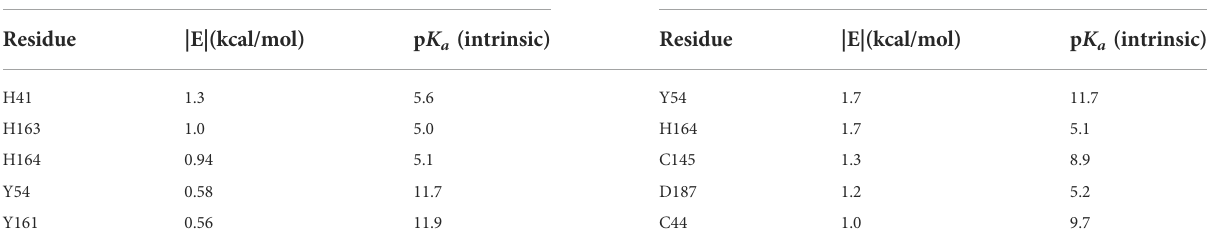
TABLE 3 Computed pairwise energies of electrostatic interaction (kcal/mol) between the two catalytic residues C145 and H41 and their strongest coupling partners in the SARS-CoV-2 main protease. Intrinsic p K a s for each residue are also listed. Top couplers to C145: p K a (intrinsic) = 8.9 Top couplers to H41: p K a (intrinsic) =